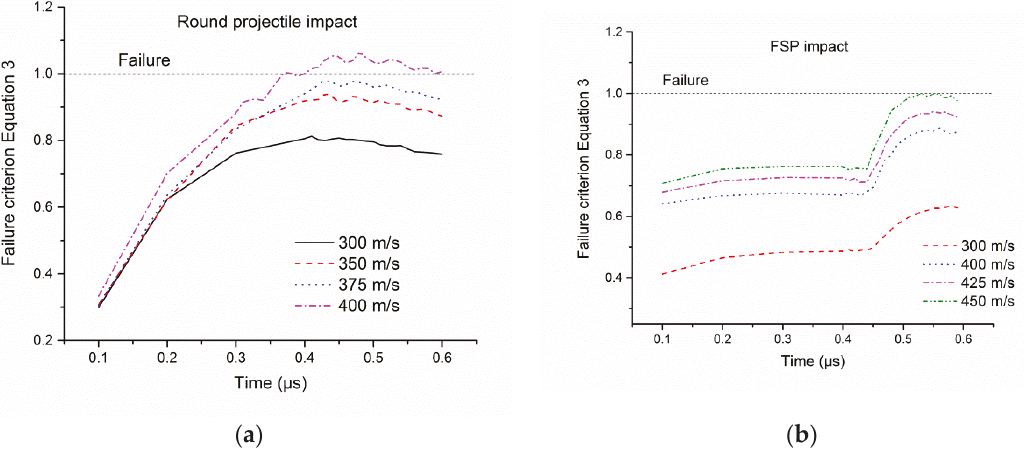
Figure 12. Failure prediction: ( a ) failure criterion for a cylindrical projectile; and ( b ) failure criterion for FSP.